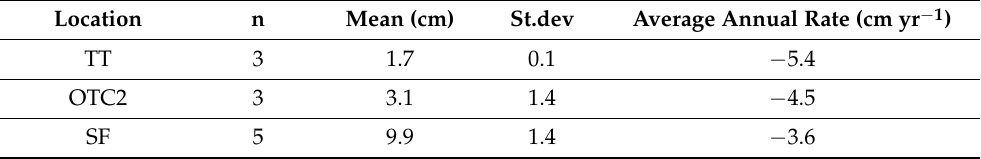
Table 3. Annual (2017–2018) averages (cm) of the aeolian sediment accumulation at the experiment locations on the EPNB and the mapped annual vertical rate (cm yr − 1 ) (Figure 9b) at the same locations. “n” refers to the number of replicates per